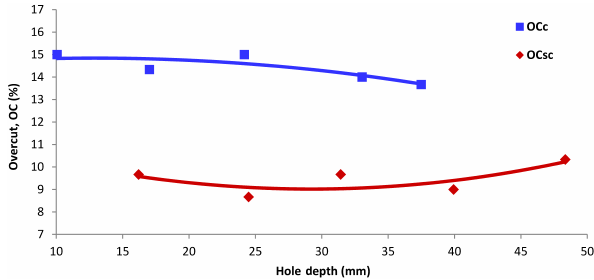
Figure 7. Photographs of drilled holes.